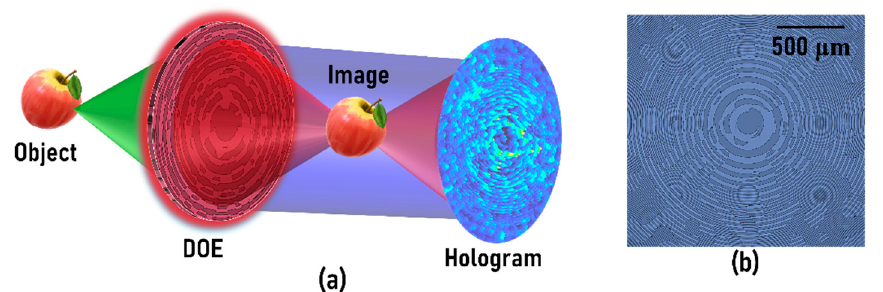
Figure 5. ( a ) Schematic of the compact optical configuration of FINCH and ( b ) optical microscope image of the bifocal